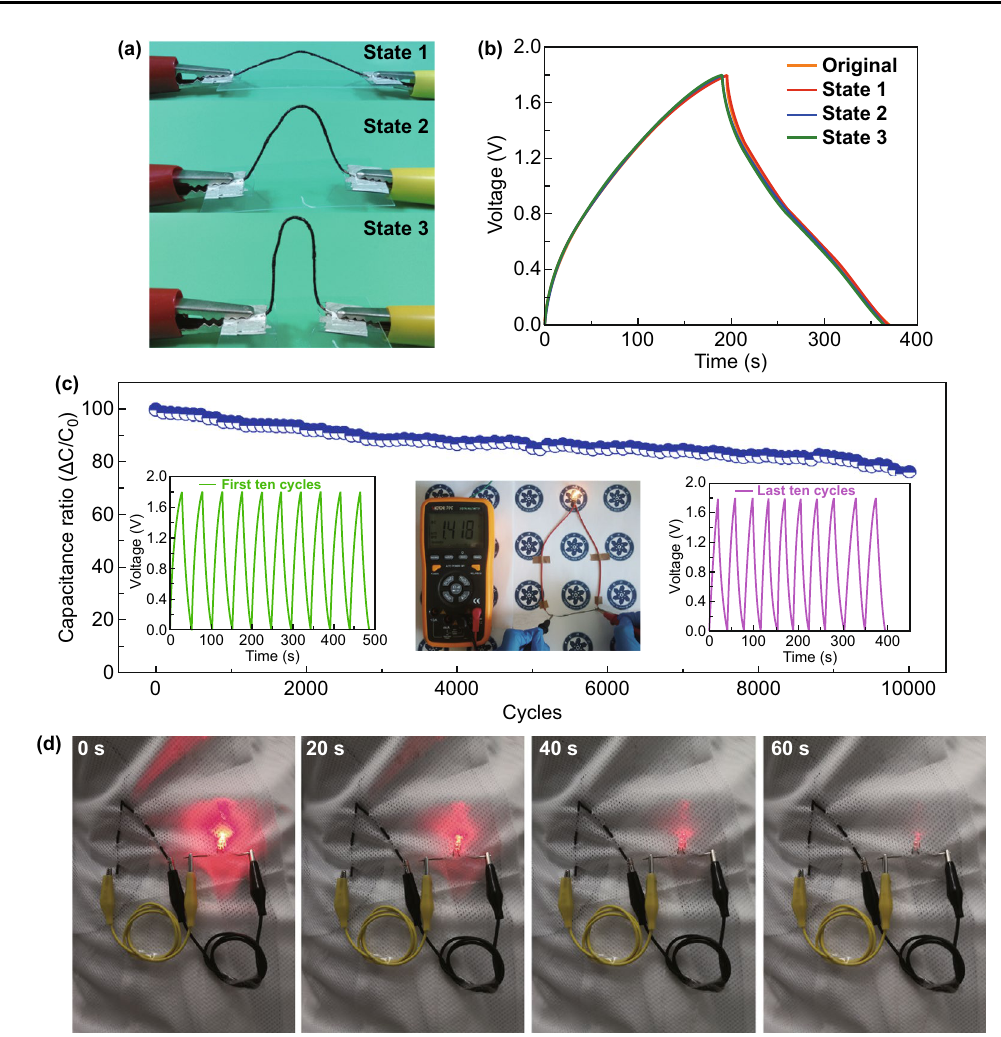
Fig. 6 a Optical images of an ACFSC at different bending state. b GCD curves obtained at different bending states corresponding to images in a . c Cycle stability tested at 90° bending states. Inset are the charge–discharge curves at the first ten cycles and the last ten cycles. The middle image shows that the ACFSC can power a LED light and the voltage of device is 1.418 V. d ACFSC powering LED, showing its potential appli‑ cability for wearable